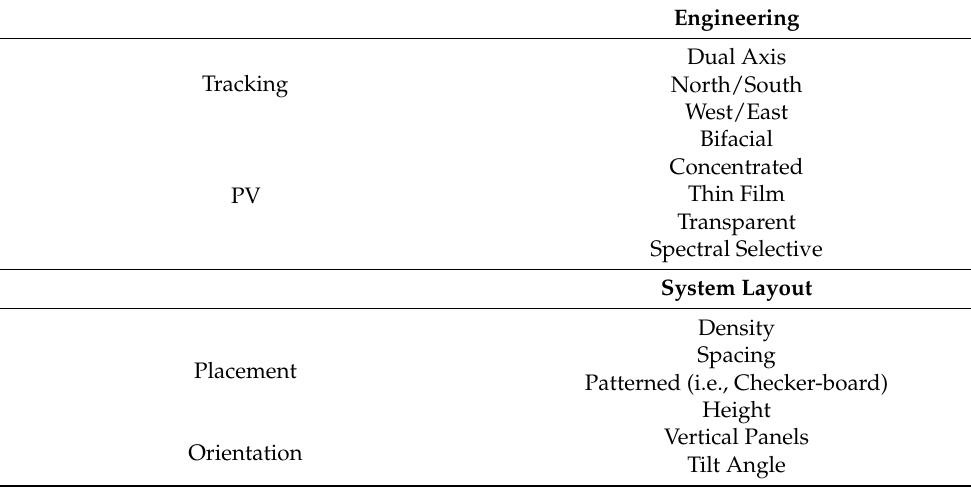
Table 1. Optimization methods modeled or field tested in the last 5